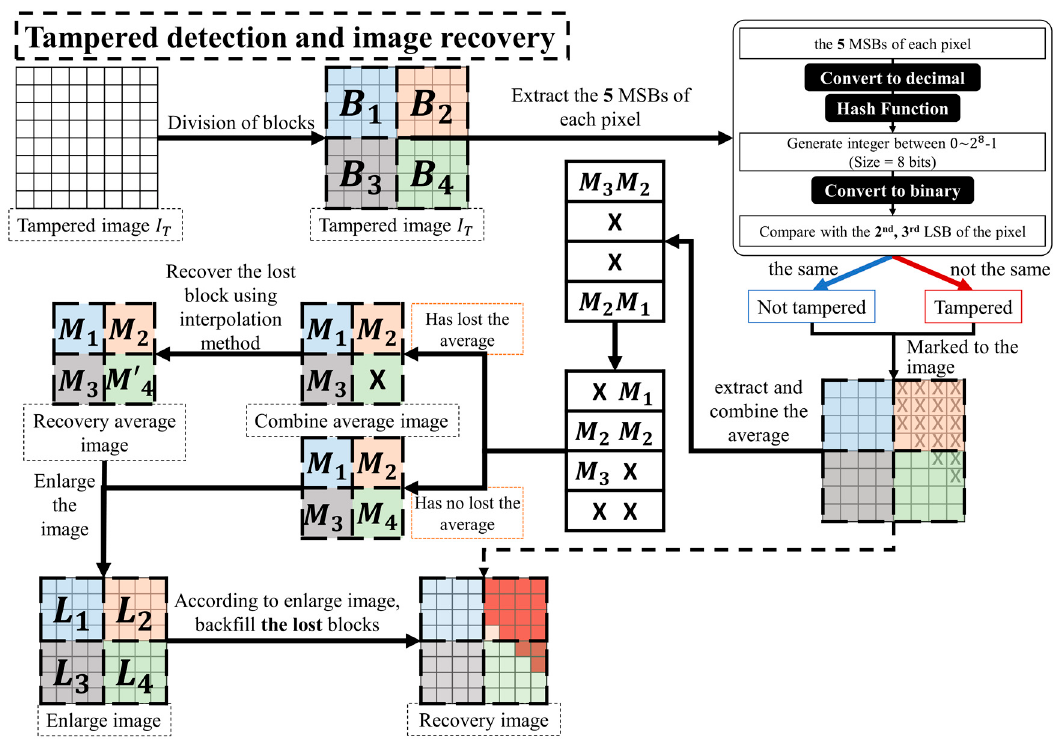
Figure 5. Flowchart of tamper detection and image recovery process based on “pixel-wise detection”.